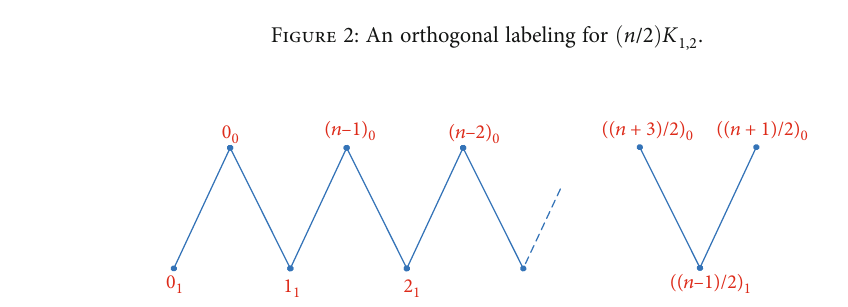
Figure 3: An orthogonal labeling for P